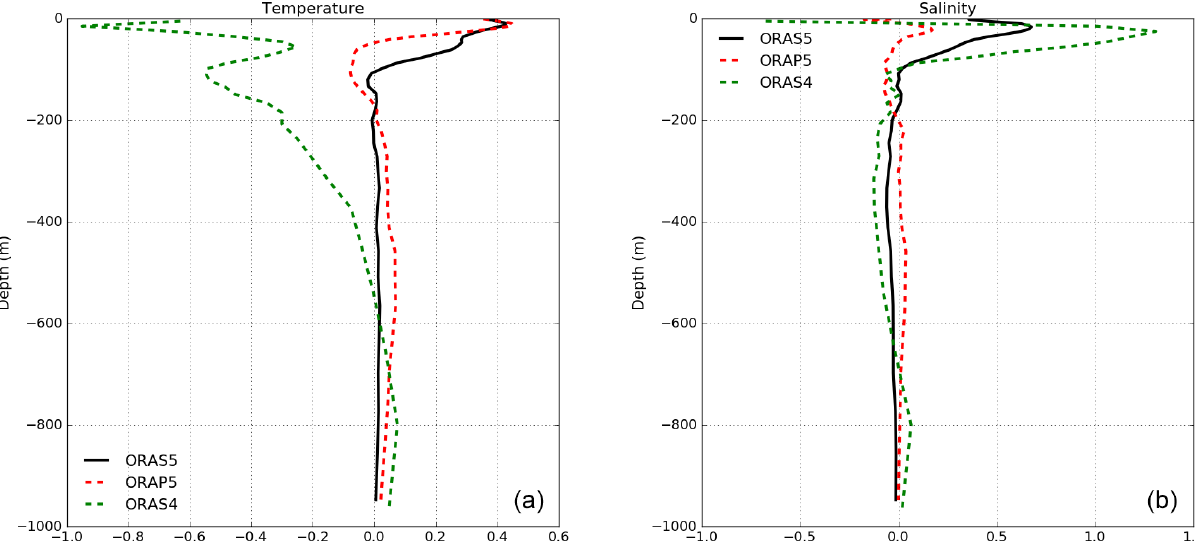
Figure 9. Vertical profile of global mean a priori bias corrections applied to (a) temperature (units are 0.01K per 10d) and (b) salinity (units are 0.001psu per 10d) for ORAS5 (black solid), ORAP5 (red dashed) and ORAS4 (green dashed).